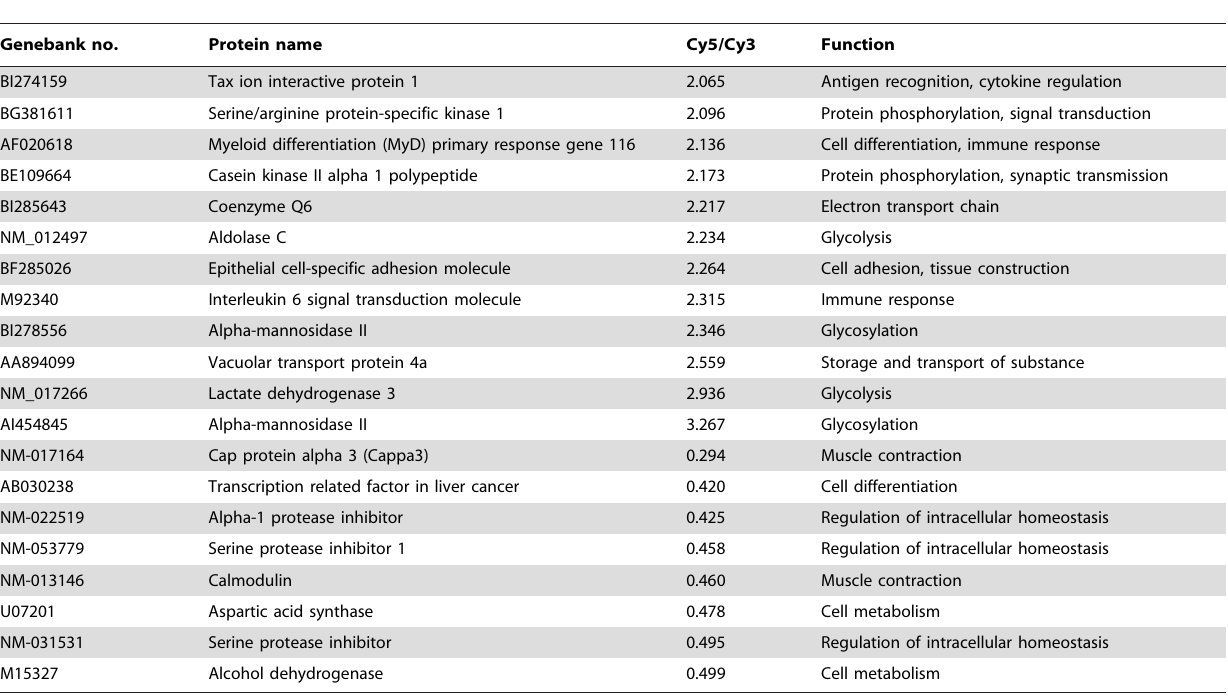
Table 3. Some of the differentially expressed genes in extraocular muscle of PTMG F344 rats.